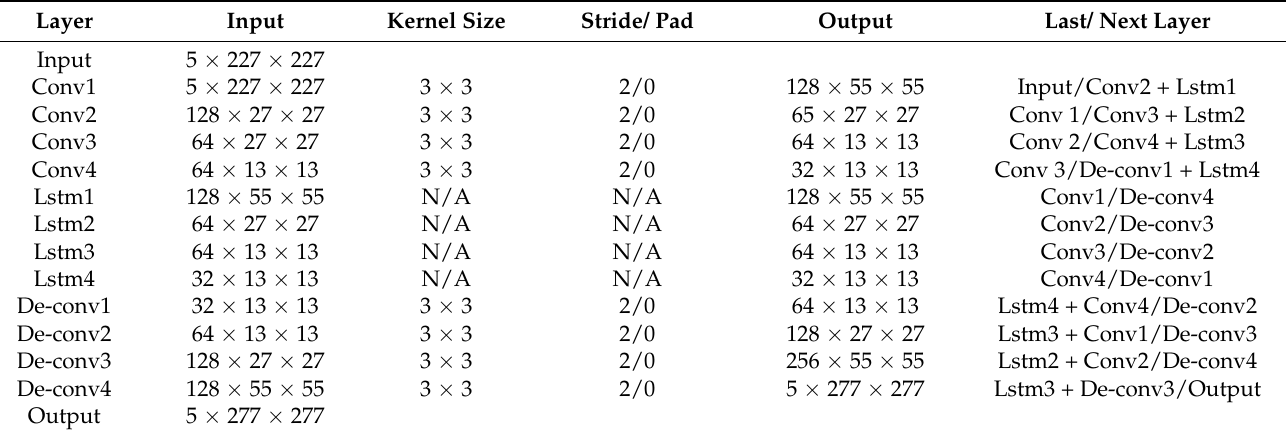
Table 1. Specifications of the CR-AE